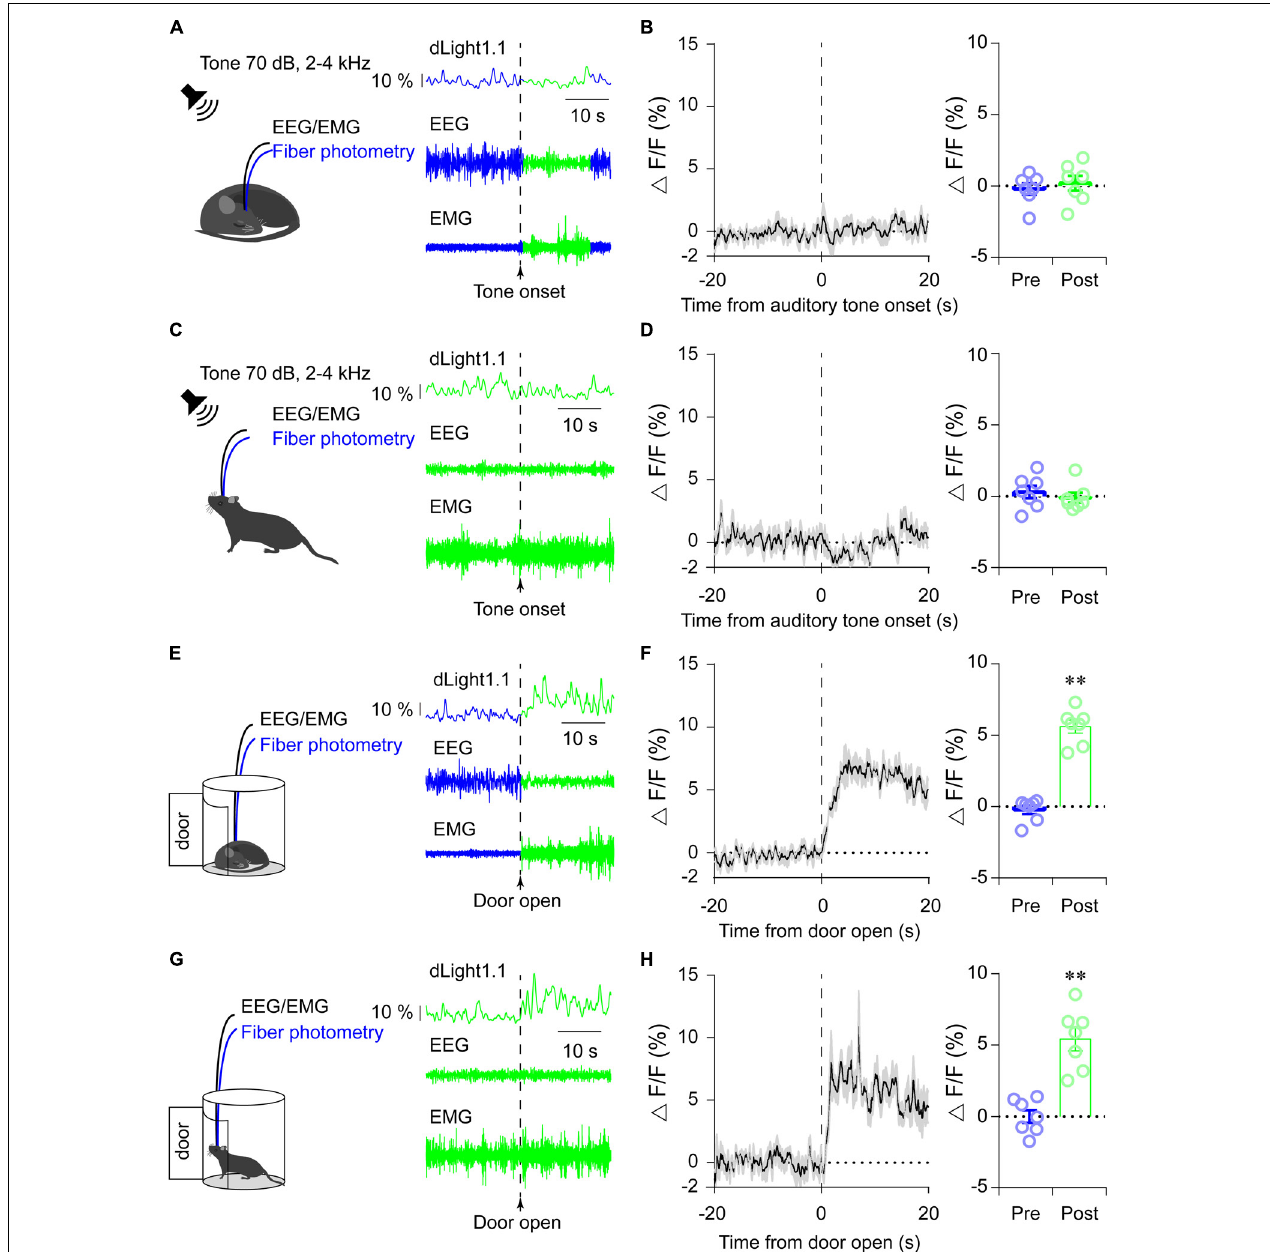
FIGURE 3 | Striatal dLight1.1 fluorescence in response to acute stimuli. (A , Left) Schematic showing high-frequency auditory tones applied in the sleep state simultaneously with fiber photometry and EEG/EMG recording. (Right) Example traces of the fluorescence signal, EEG, and EMG before and after the onset of the auditory tone during sleep. (B , Left) The time course of the striatal dLight1.1 signal in response to auditory tones when mice were sleeping. (Right) Average fluorescence before and after onset of the auditory tone ( t 6 = 1.243, P = 0.260). (C , Left) Schematic showing auditory tones applied in the awake state simultaneously with fiber photometry and EEG/EMG recording. (Right) Example traces of the fluorescence signal, EEG, and EMG before and after the onset of the auditory tone during the awake state. (D , Left) The time course of the striatal dLight1.1 signal in response to auditory tones when mice were awake. (Right) Average fluorescence before and after onset of the auditory tone ( t 6 = 1.771, P = 0.127). (E , Left) Schematic showing the sudden opening of the recording-cage door during the sleep state. (Right) Typical traces of the fluorescence signal, EEG, and EMG before and after the onset of the door-opening stimulus during sleep. (F , Left) The time course of the striatal dLight1.1 signal in response to the door-opening stimulus while the mice were sleeping. (Right) Average fluorescence before and after onset of the door-opening stimulus ( t 6 = 12.15, ∗∗ P < 0.0001). (G , Left) Schematic showing the sudden opening of the recording-cage door while mice were in the awake state. (Right) Typical traces of the fluorescence signal, EEG, and EMG before and after the onset of the door-opening stimulus during the wake period. (H , Left) The time course of the striatal dLight1.1 signal in response to the door-opening stimulus while the mice were awake. (Right) Average fluorescence before and after onset of the door-opening stimulus ( t 6 = 11.18, ∗∗ P < 0.0001).